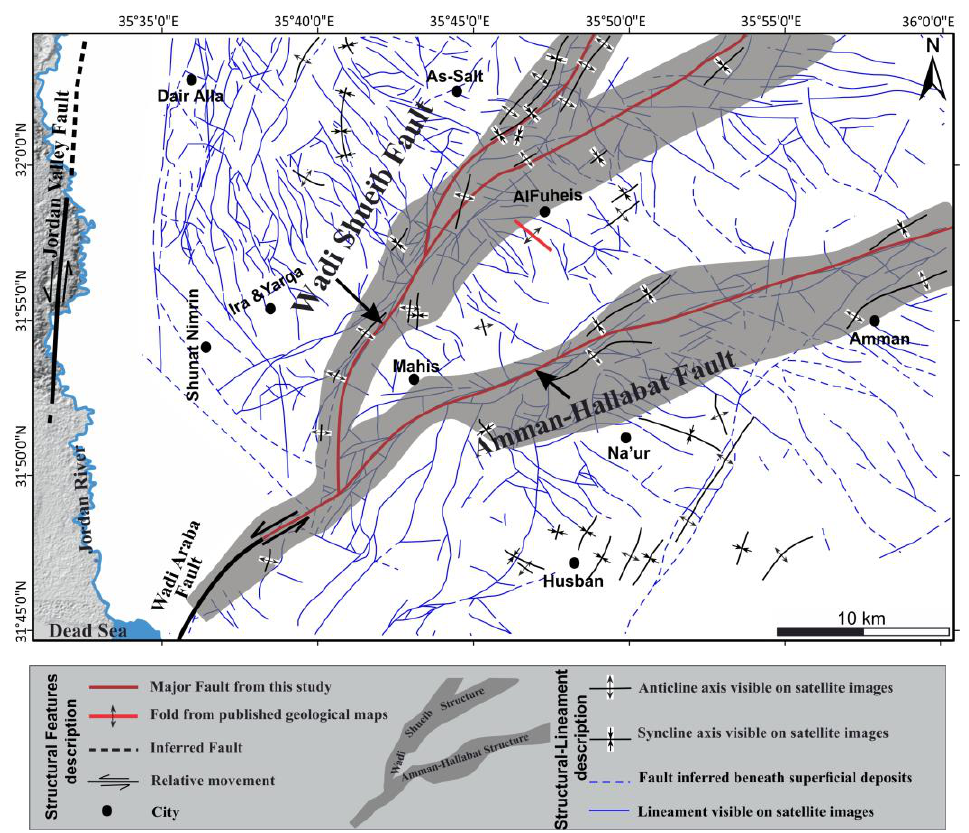
Figure 9. Configuration of the Wadi Shueib and Amman-Hallabat Faults and their spatial relationship with the Wadi Araba Fault.